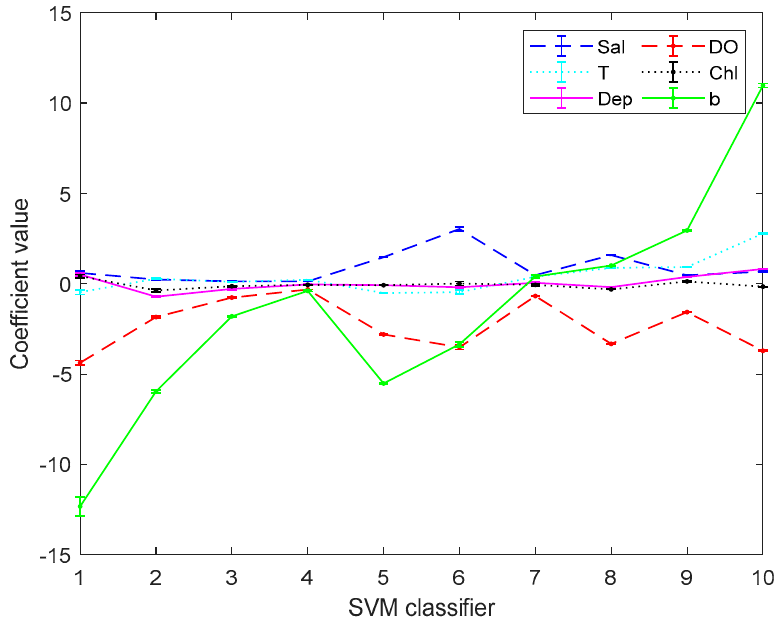
Figure 5. Coefficients by Support Vector Machine (SVM) before data preprocessing. Figure 5. Coe ffi cients by Support Vector Machine (SVM) before data preprocessing.